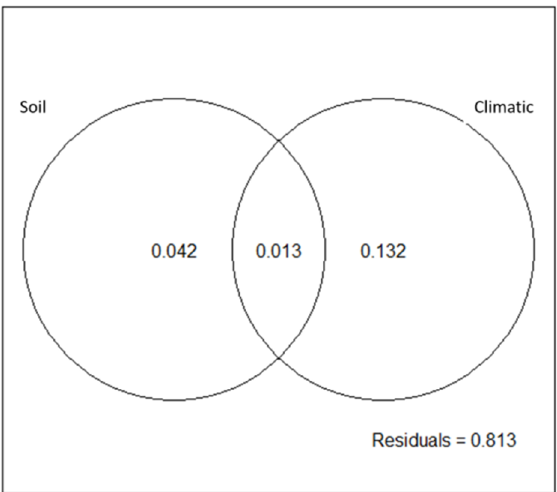
Figure 2. Redundancy analysis and partition of variance for soil and climatic variables, for Pinus arizonica at northwestern Mexico. Results for P. durangensis were all non-significant and are not shown.